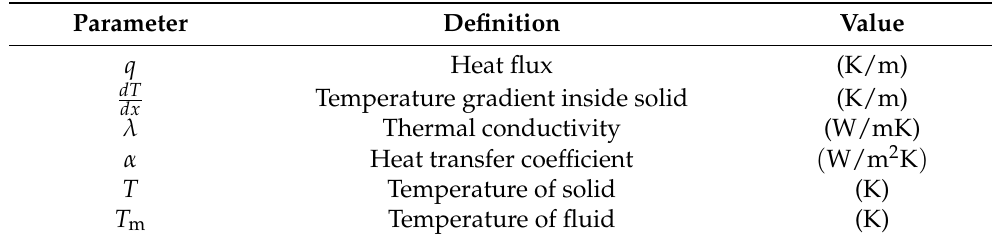
Table 2. Parameters of Newton’s cooling law and Fourier’s